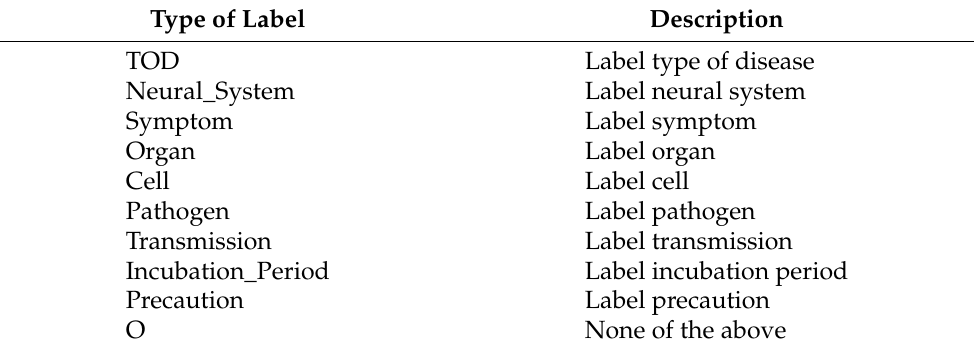
Table 2. Sequence labels and their